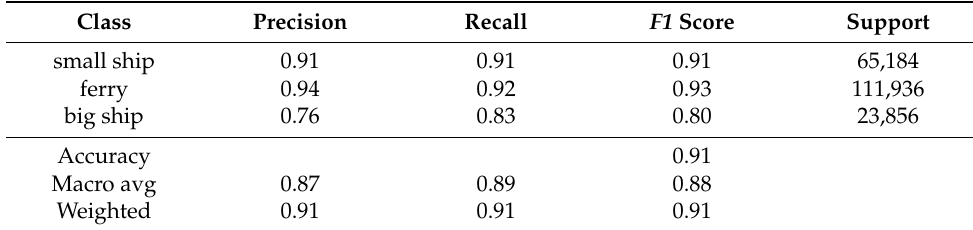
Table 6. The precision, recall and F1 score for each class.